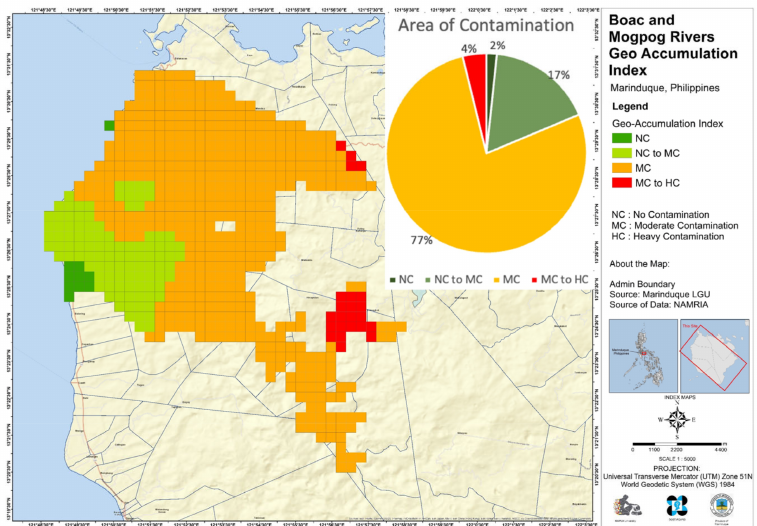
Figure 7. Boac and Mogpog geo-accumulation index map of